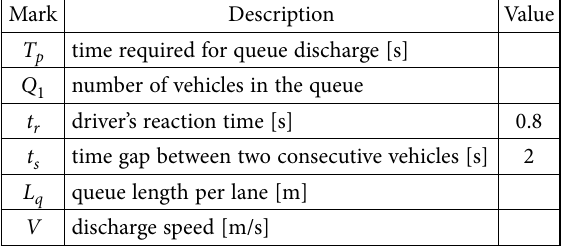
Table 3. Parameters for computation of queue discharge